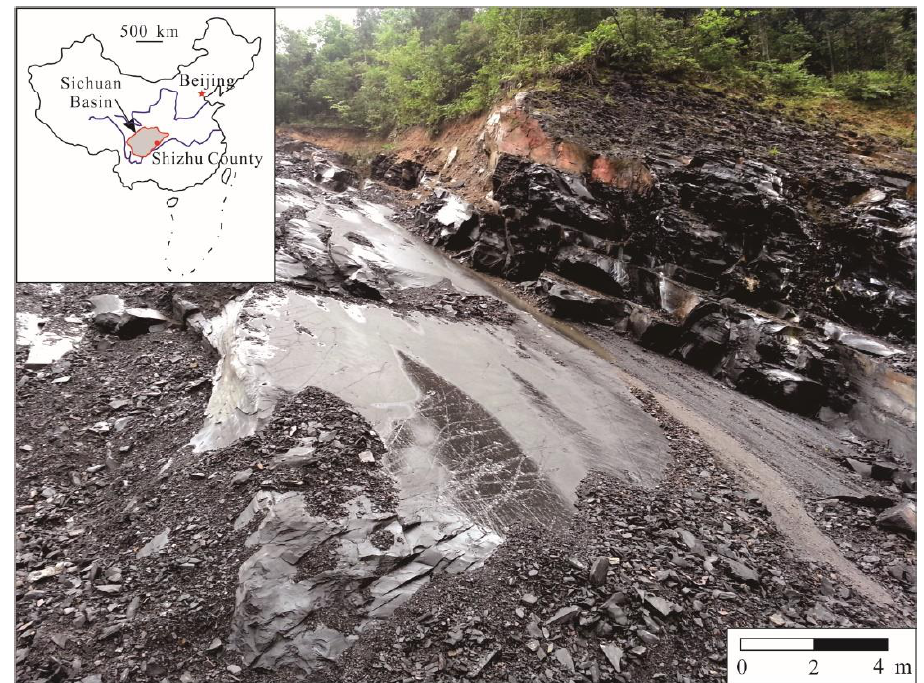
Figure 1. Location site and outcrop of the Longmaxi Shale in Shizhu County, Sichuan Basin, China.